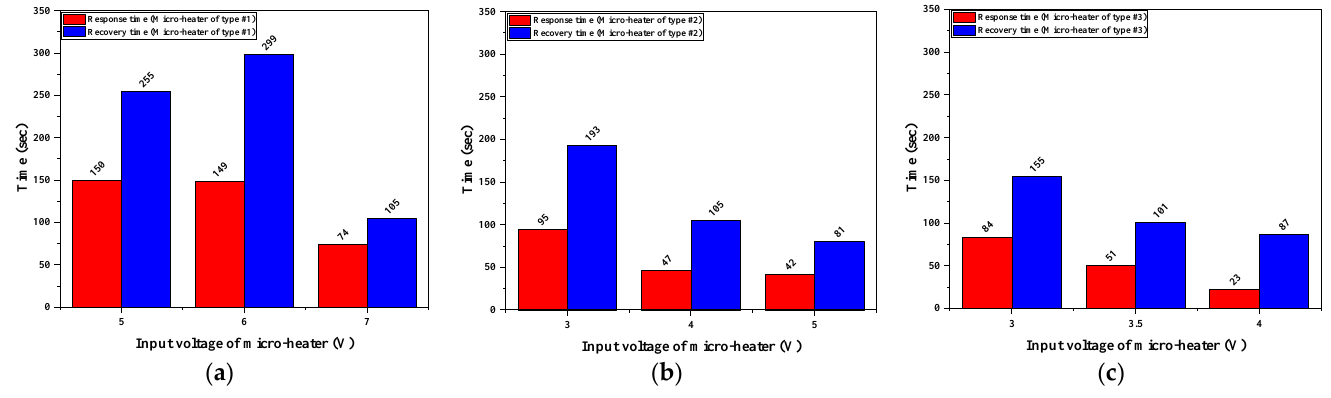
Figure 8. Measured response and recovery time of the SnO 2 -based H 2 S microsensor with micro-heaters of ( a ) type #1, ( b ) type #2, and ( c ) type #3 as a function of input voltage of micro-heater. Response and recovery times considerably decreased with the increase in operating temperature, which is controlled by the input voltage of the micro-heater. At a lower input voltage, the micro-heater of type #3 had a shorter response and recovery time compared to that of type #1 and #2, as it produced a more adequate thermal energy for an active and rapid reaction between H 2 S and oxygen species (O 2 − , O − and O 2 − ) on the SnO 2 surface, owing to its superior heating ability. To initiate a reaction between mole- cules, they must be close to each other, and each molecule must have an energy greater than the energy required for the reaction (i.e., activation energy, Ea ). The activation en-